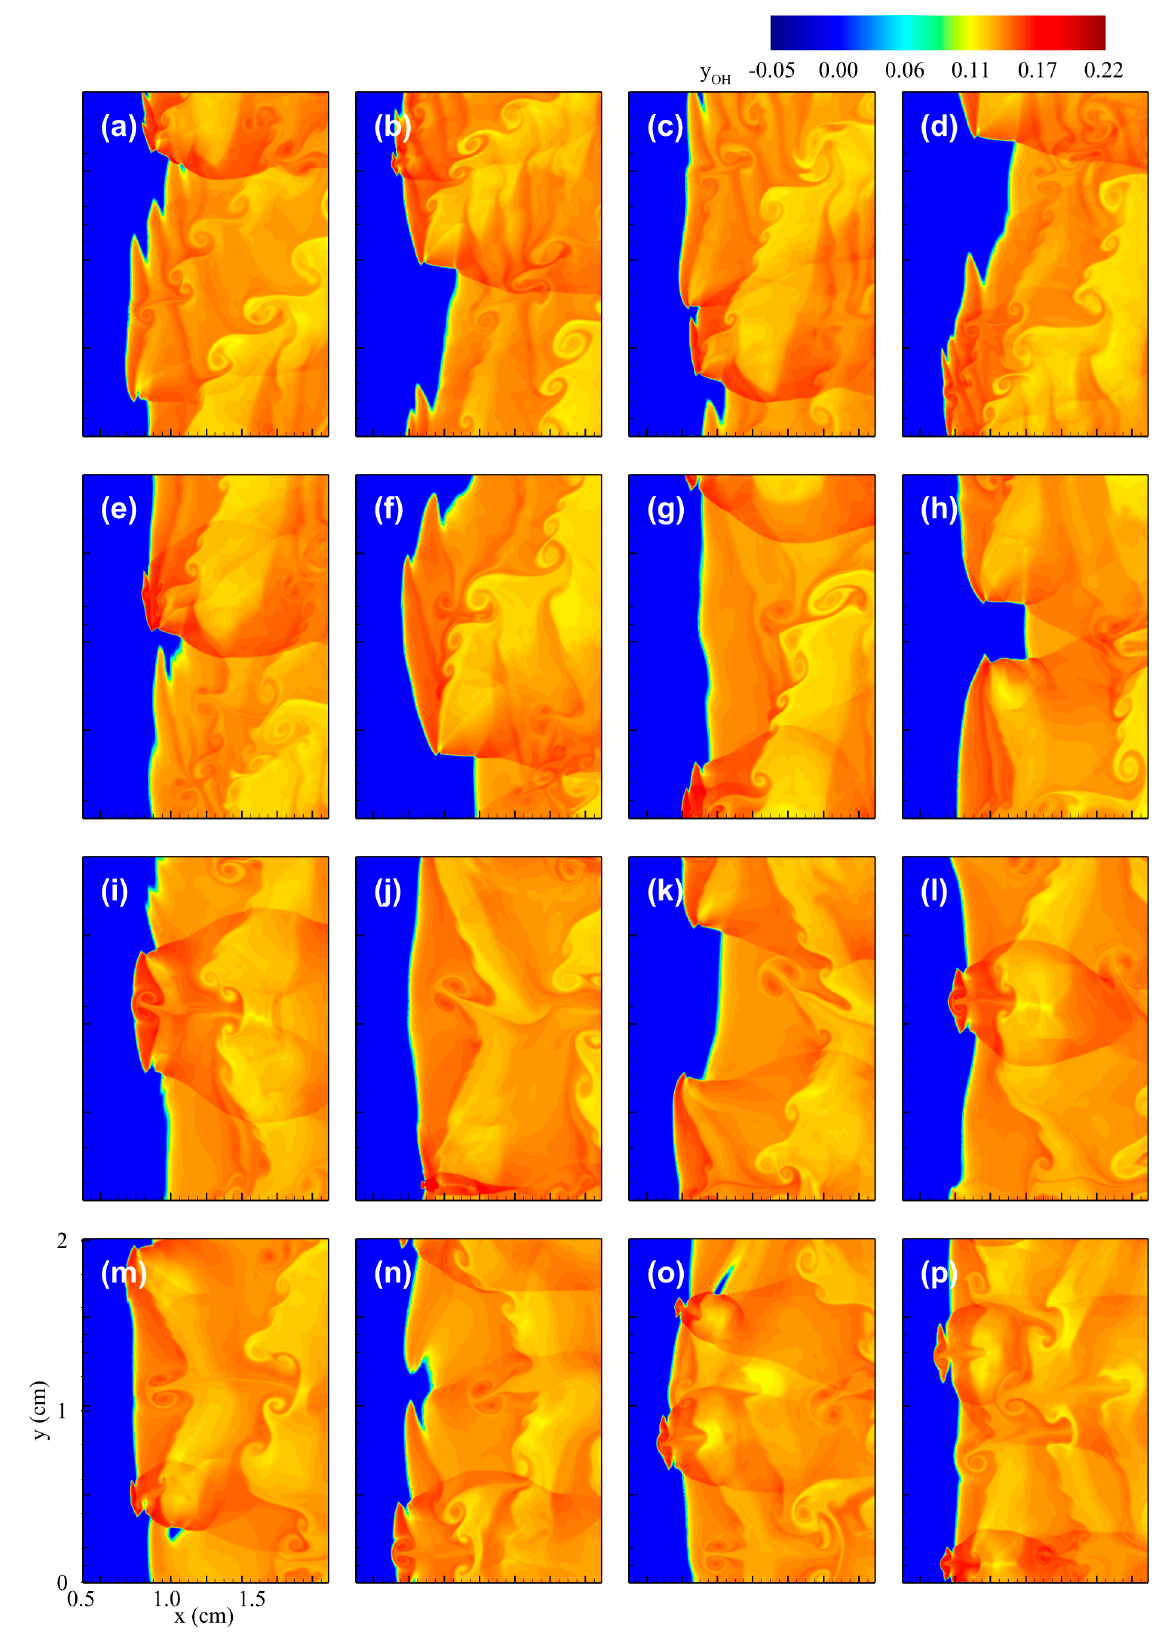
Figure 15. OH distribution during the bifurcation process (depicting the slow and fast reactions). The subfigures are plotted in temporal sequence ( a – p ).